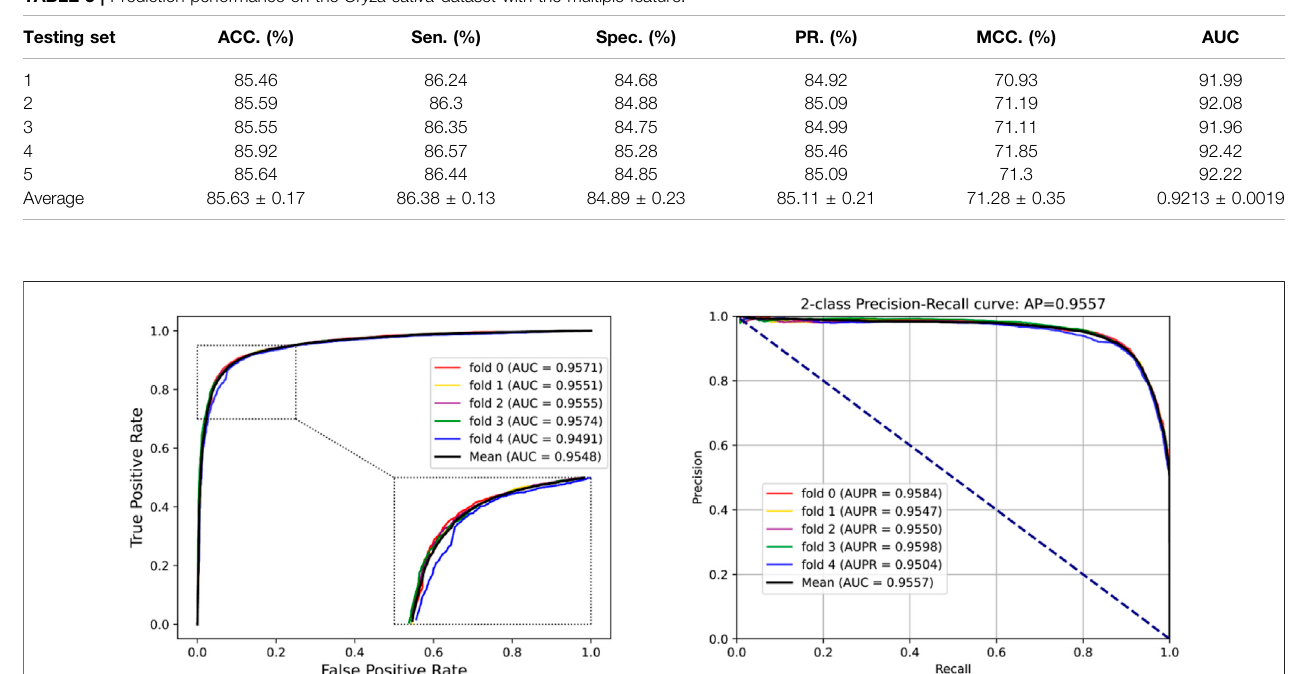
FIGURE 1 | ROC and PR curves yielded by the DWPPI model on the A. thaliana dataset with the multiple feature.